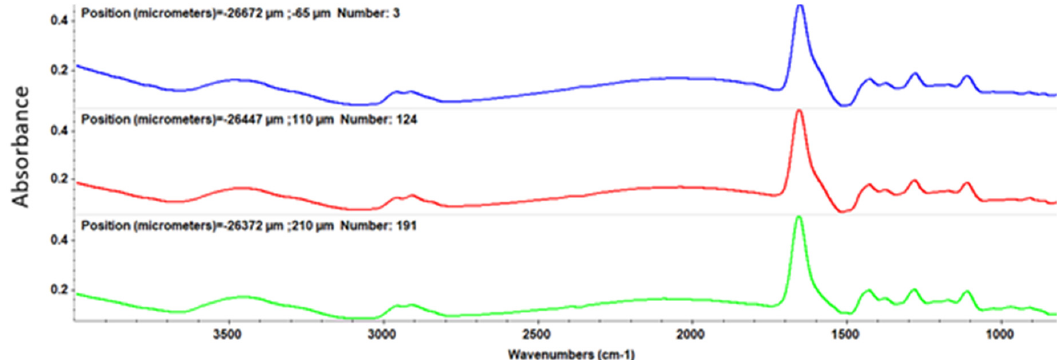
Nanomaterials 2021 , 11 , x FOR PEER REVIEW Figure 6. IR spectra of PVP/ZnO@LiN dropcast. At a laser fluence of 200 mJ/cm 2 (Figure 7), the intensity of absorption bands is low due to the reduced amount of sample deposited on the substrate, while, at a laser fluence of 300 mJ/cm 2 (Figure 8), clear peaks are registered.